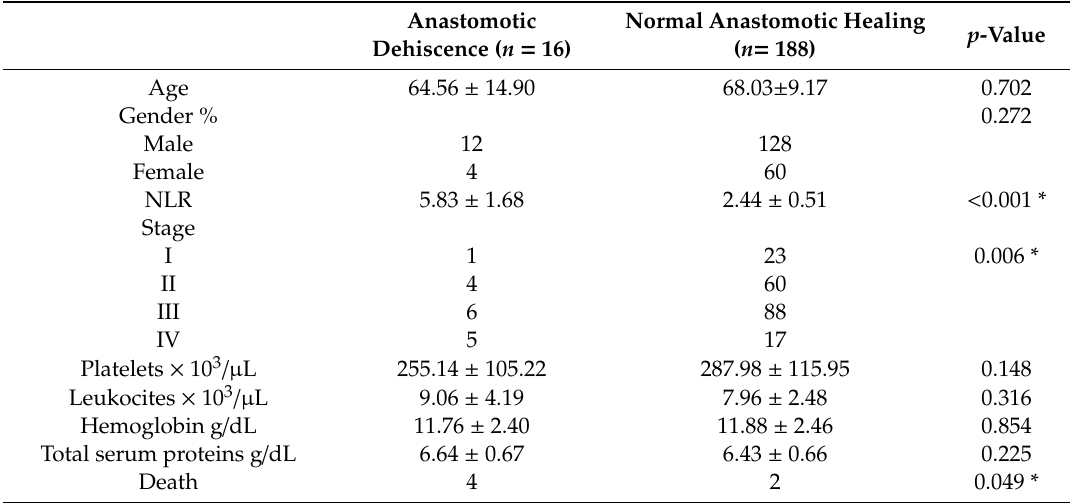
Table 3. Variations between the group with anastomotic dehiscence and the group with normal anastomotic